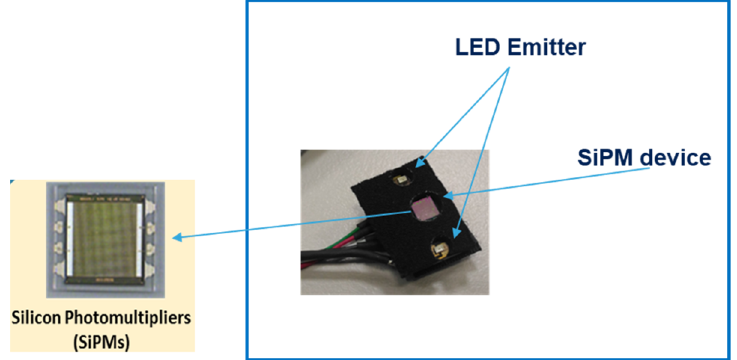
Figure 2. The proposed PPG coupled sensing device (LED + silicon photomultipliers (SiPMs)).